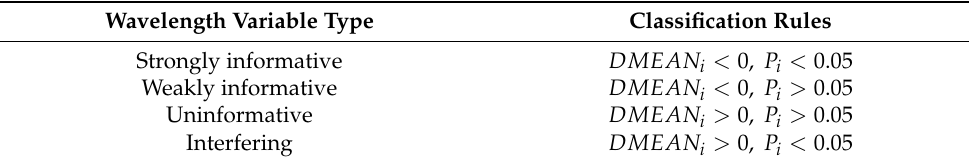
Table 1. Variable classification